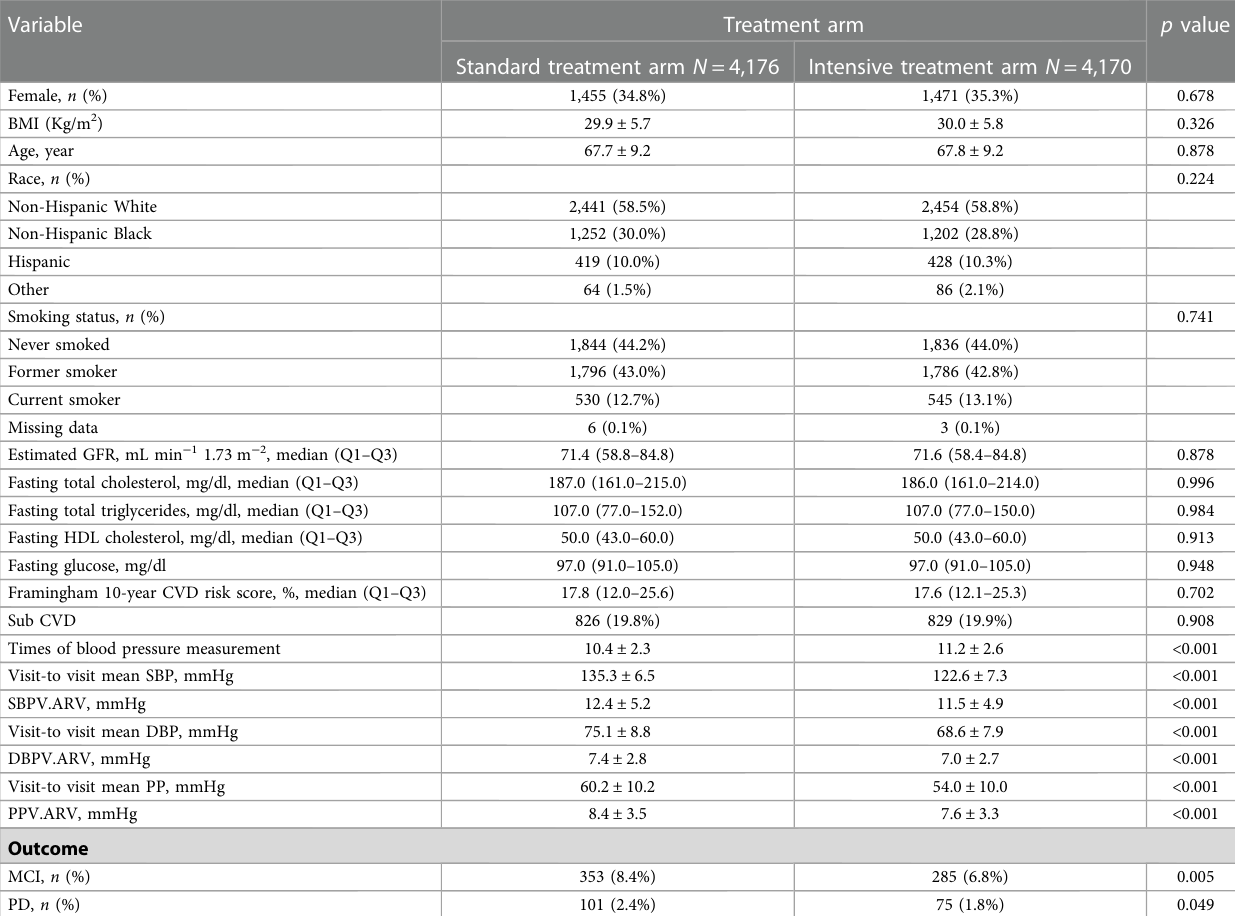
TABLE 1 Baseline characteristics, visit-to-visit BP, BPV and outcome of the study